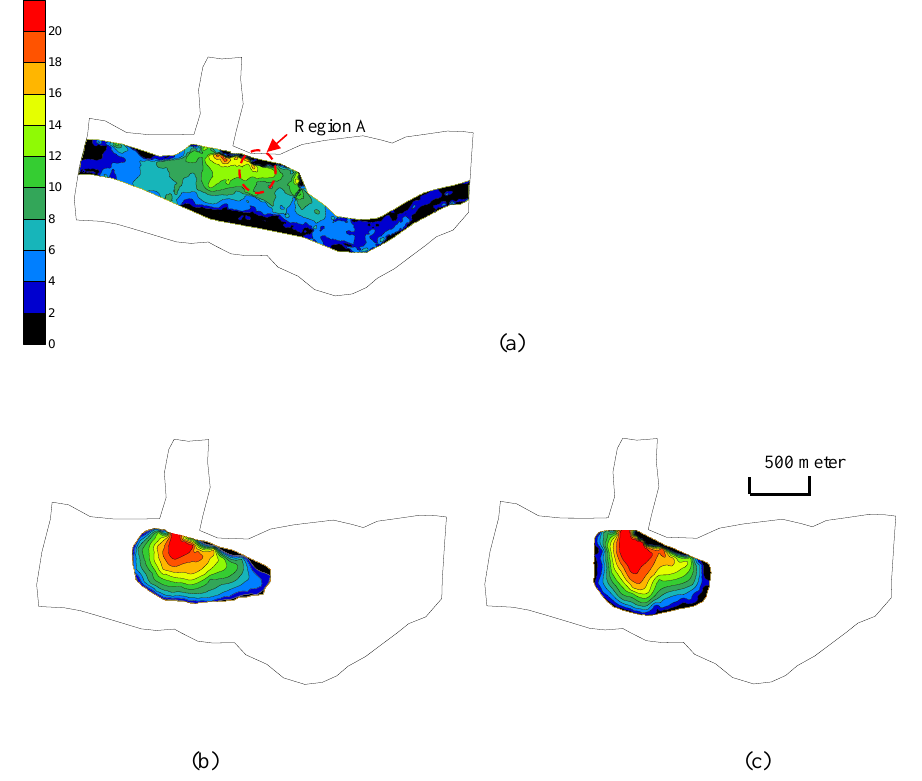
Figure 7. Contours of deposit thickness Fig. 7. Contours of deposit thickness. (a) The contour of the prototype; (b) the contour of the model in which λ M ∗ = 1; and (c) the contour of the model without using the M conservation and in which Q r =